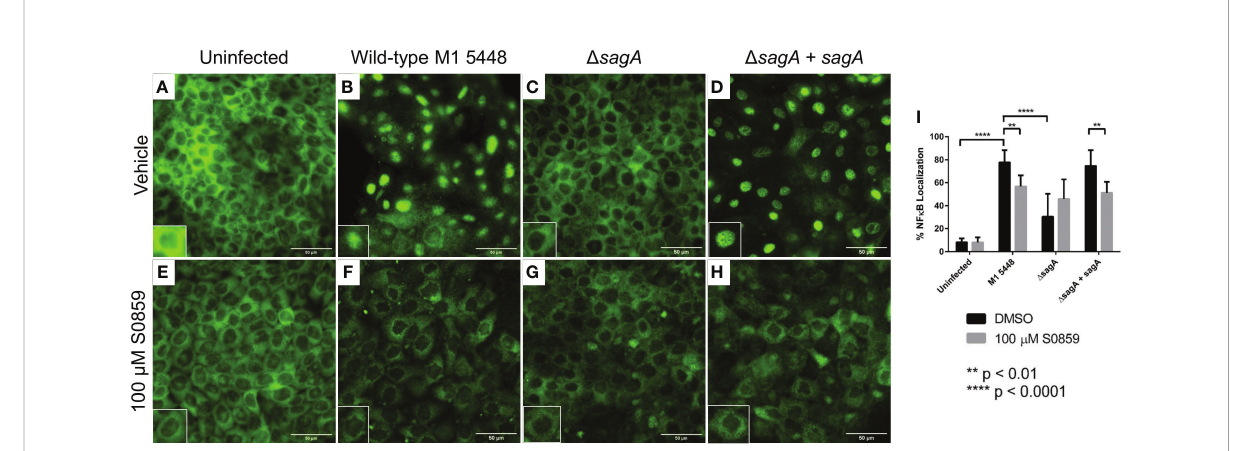
FIGURE 3 S0859 reduces SLS-dependent NF- k B activation in human keratinocytes. Representative immuno fl uorescence images (60x) of GAS infections after 4 hours (MOI 10) in the presence of vehicle (DMSO, (A – D) or 100 m M S0859 (E – H) . A Rb a NF- k B primary antibody (1:50) and Gt a Rb IgG AlexaFluor 488 (1:200) were used for this experiment. The scale bar indicates 50 µm. Minimal NF- k B nuclear localization was observed in the uninfected + vehicle (A) , uninfected + 100 m M S0859 (E) , D sagA + vehicle (C) , and D sagA + 100 m M S0859 (G) conditions. Most cells in the WT + vehicle (B) and D sagA + sagA + vehicle (D) exhibited strong nuclear localization of NF- k B, which was signi fi cantly reduced when these infections were performed in the presence of 100 m M S0859 (F, H) . Each panel has an inset that highlights a particular cell, indicating either NF- k B localized to the cytoplasm (A, C, E – H) or the nucleus (B, D) . (I) 10 fi elds from each condition were imaged, and the percentage of cells with NF- k B nuclear localization was calculated by counting the number of cells with NF- k B localized to the nucleus, and dividing by the total number of cells in the fi